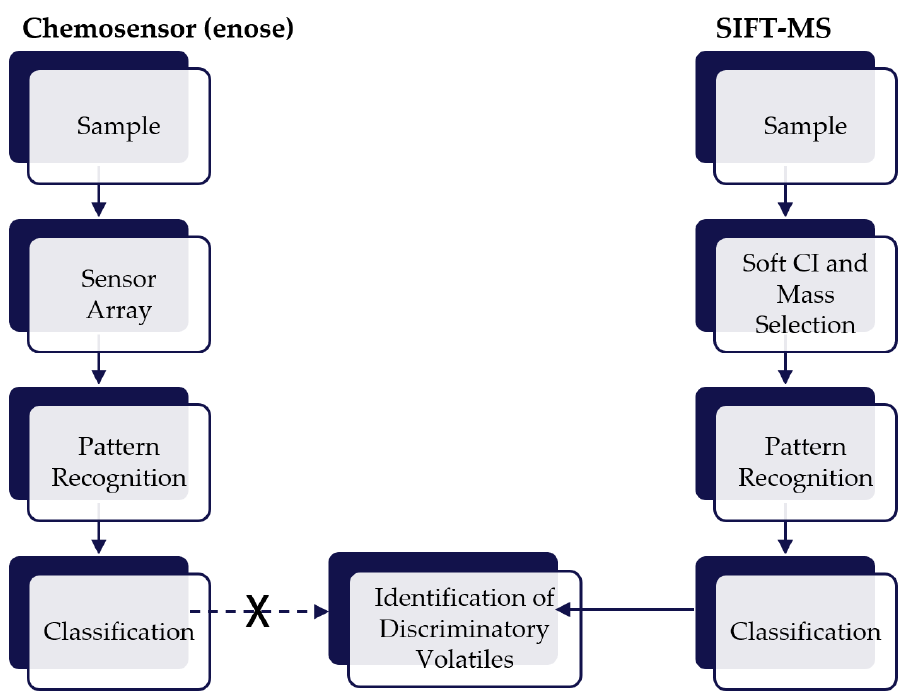
Figure 8. A simplified schematic representation of the parallels between chemosensors (enoses) and untargeted SIFT-MS sample classification approaches. SIFT-MS has an advantage in that com- pounds cause sample discrimination can often be